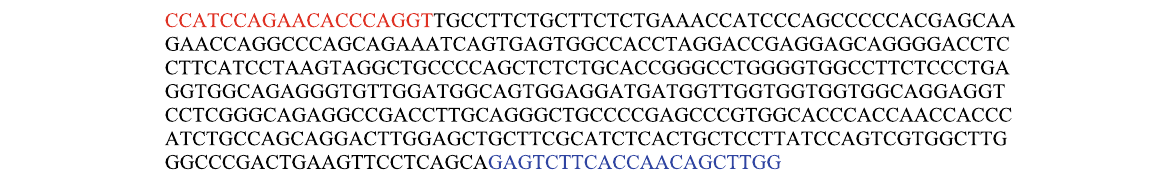
Fig. 2 The sequence analysis of goat GH6 amplified fragment. Forward and reverse primers are shown in red and blue color, respectively